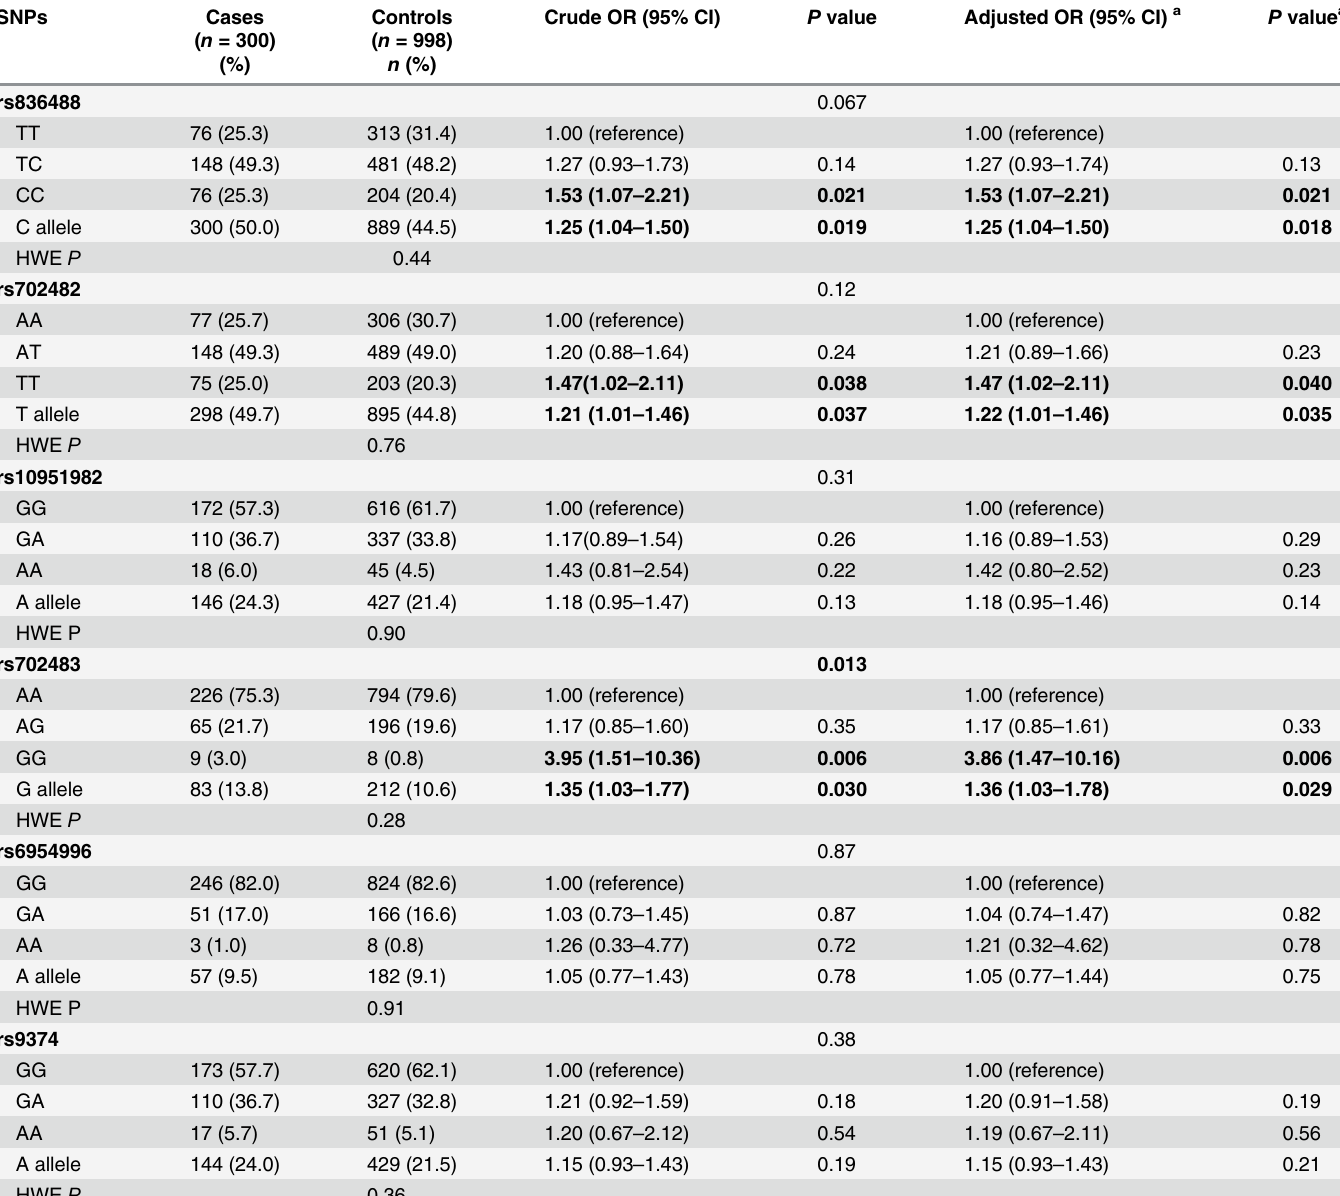
Table 3. Genotype and allele distribution of RAC1 gene in renal transplant recipients and healthy subjects.